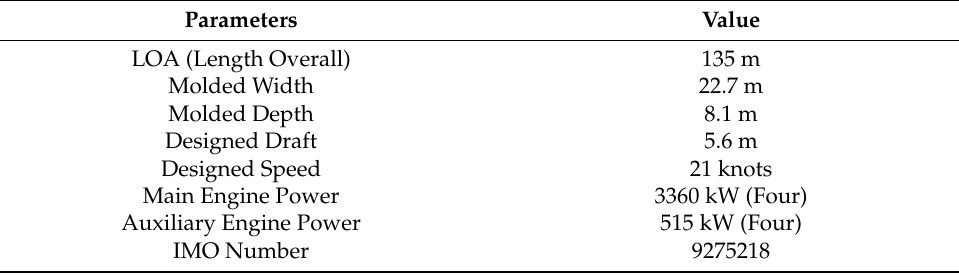
Figure 6. Main route of the case ship. Table 1. Principal particulars of the case